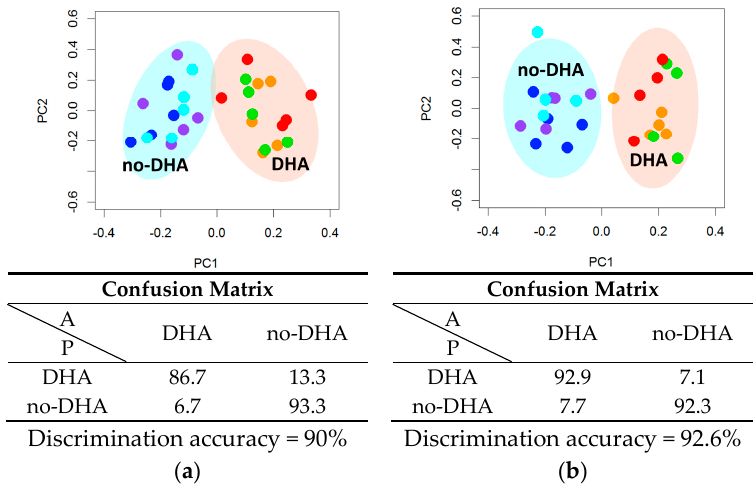
Figure 5. Cytoplasmic metabolomic phenotyping by nuclear magnetic resonance (NMR) analysis of cells not supplemented and supplemented cells with docosahexaenoic acid (DHA), alone or in combination with protocatechuic acid (PCA) or propionic acid (PRO), after ( a ) 6 h and ( b ) 24 h supplementation. Principal component analysis and canonical analysis (PCA-CA) score plots: PC1 vs. PC2. In each group, five samples derived from three independent experiments were analyzed. Each symbol represents a different sample. Blue symbols = NS; purple symbols = PCA; cyan symbols = PRO; orange symbols = DHA; green symbols = DHA + PCA; red symbols = DHA + PRO. For each PCA-CA model, the confusion matrix and the discrimination accuracy are reported; A: actual classes; P: predicted classes.